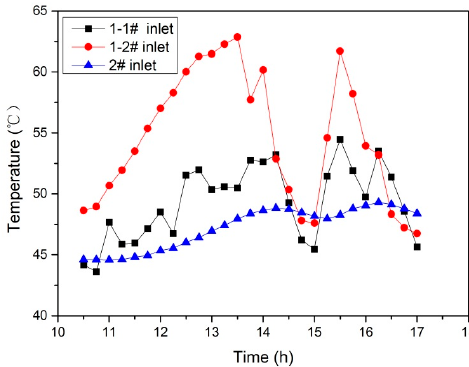
Figure 4. Water temperatures of the tank inlets.